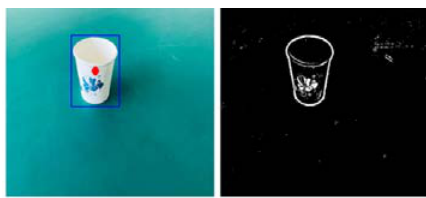
Fig. 7. Segmentation effect of adaptive threshold algorithm.